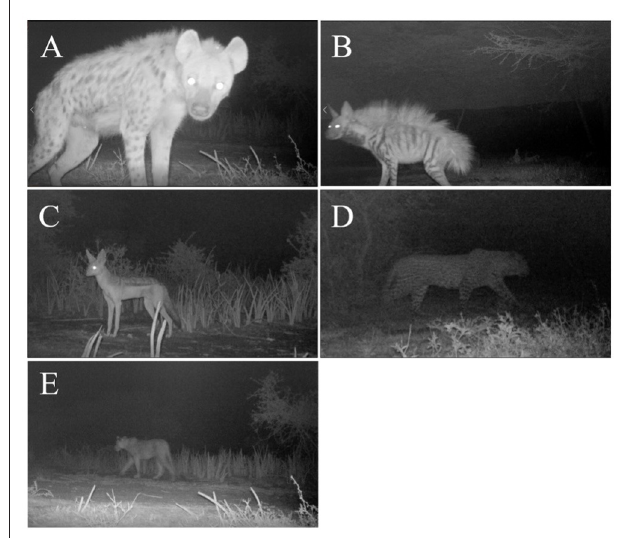
FIGURE 4 | The carnivore species detected on motion-activated cameras at 12 bomas in Central Kenya from September, 2018 to May, 2019. The five potentially depredating species recorded to encounter livestock were: (A) Spotted hyena ( Crocuta crocuta ), (B) Striped hyena ( Hyaena hyaena ), (C) Black-backed jackal ( Canis mesomelas ), (D) Leopard ( Panthera pardus ), and (E) African lion ( Panthera leo